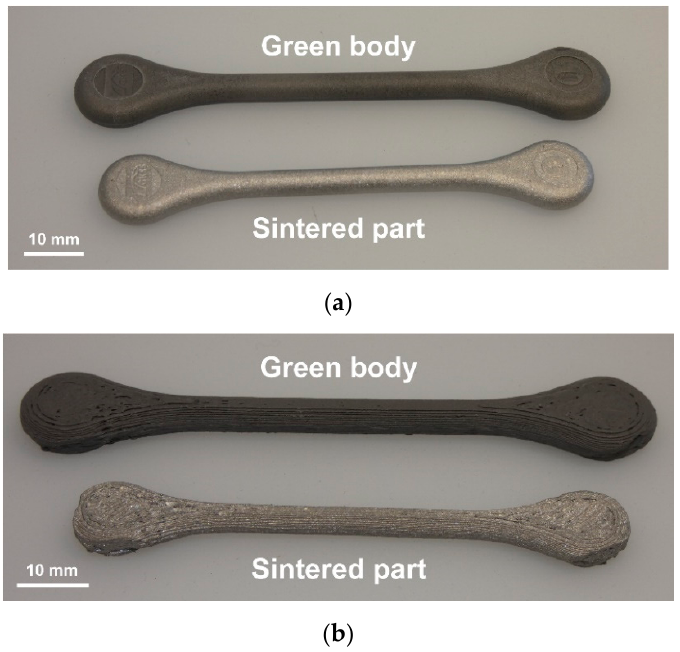
Figure 1. Green body and sintered titanium tensile bar using ( a ) metal injection molding (MIM) and ( b ) fused filament fabrication (FFF). The length of the injection-molded (MIM) tensile bar is 89 mm.